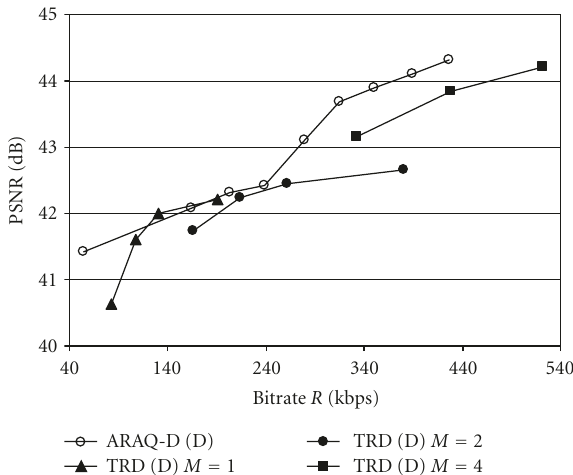
Figure 10: R-D curves for the Carphone (C) sequence obtained with the ARAQ-D technique, compared to the performance of a TRD system.